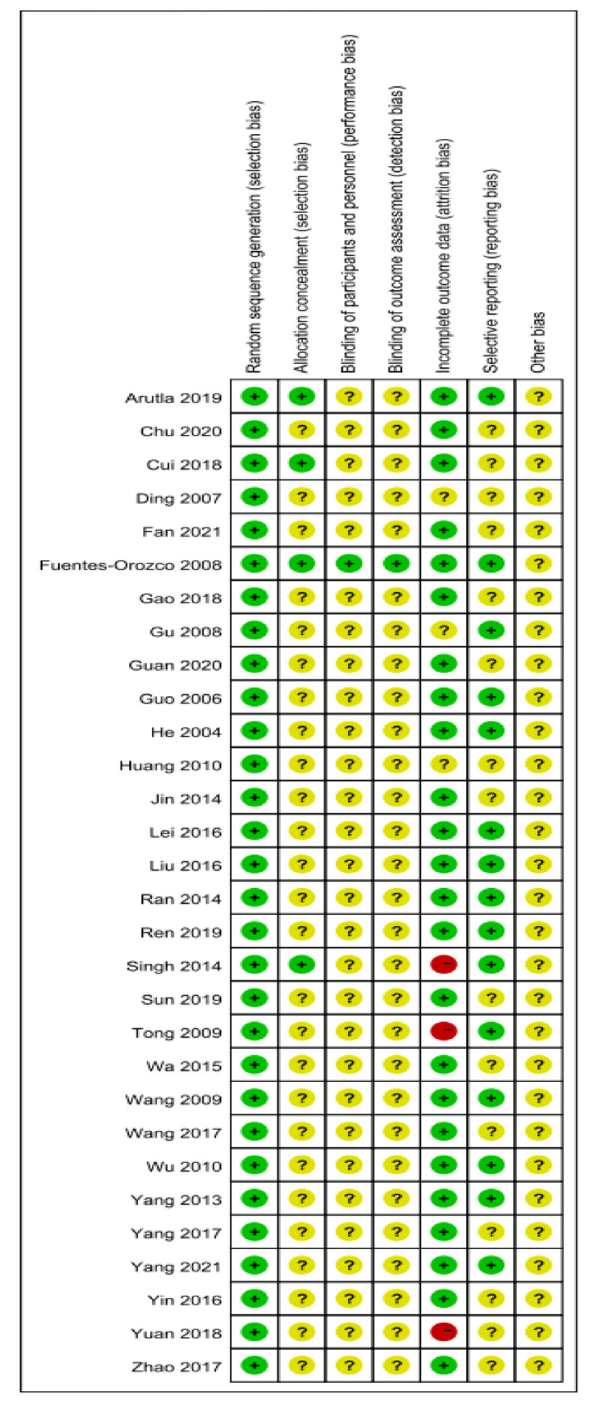
indicators ( Figures 20 , 21 ), serum amylase recovery time ( Figure 22 ), and response rate ( Figure 23 ). In Figures 4 – 23 , “experimental” represents the parenteral or enteral